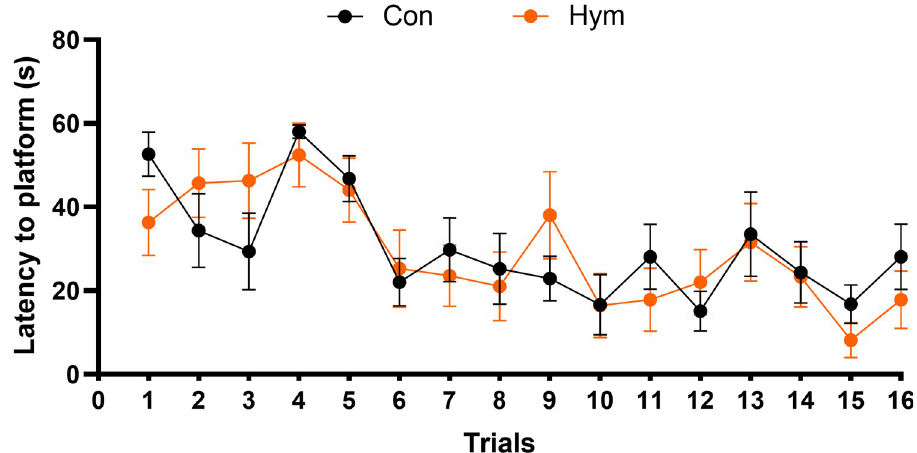
Fig 3. Spatial learning (day 1–4, trial 1–16) in the control rats (Con, n = 8) and rats infected with H . diminuta (Hym, n = 7) in the Water Maze test. Latency to the platform is parameter used to specify time to escape from water during acquisition trials using a submerged